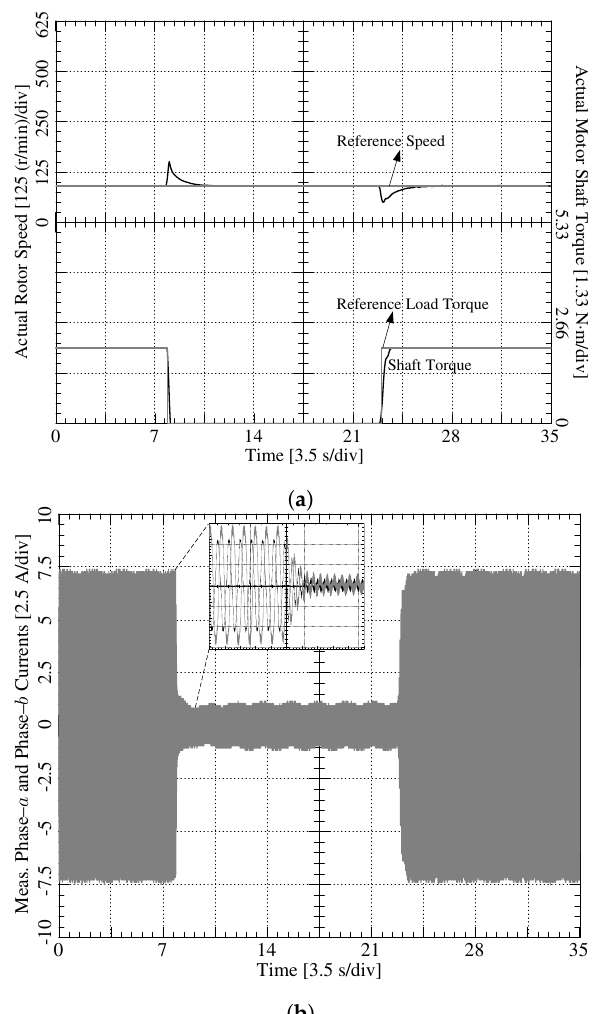
Figure 13. ( a ) Experimental transient and steady-state low speed (90 r/min); ( b ) phase currents’ response when full load (2 N·m) rejection and injection are performed at t = 7.87 s and t = 23 s respectively with K = 5 (high) while R s is increased by 82.35% and λ f is decreased by